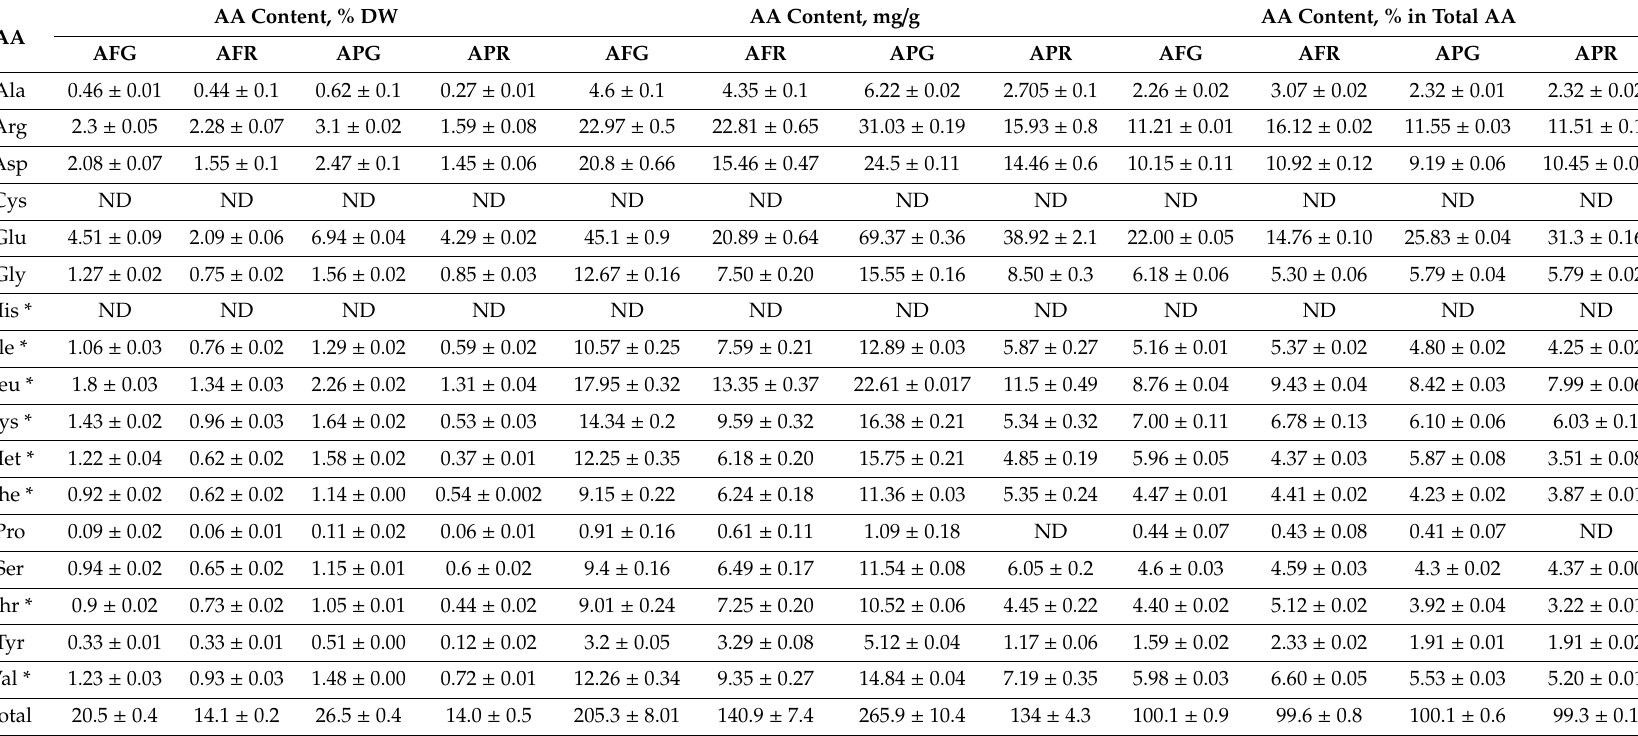
Table 2. Amino acid concentrations in biomass of A. filiculoides and A. pinnata grown under normal and stress